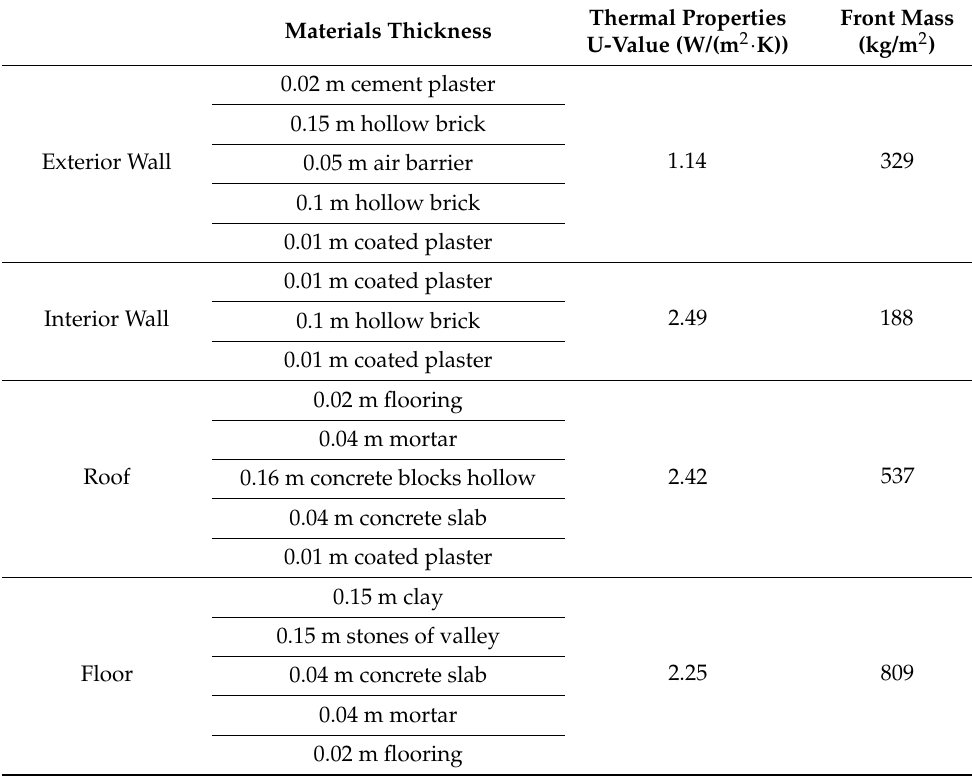
Table 2. Thermal characteristics of the building